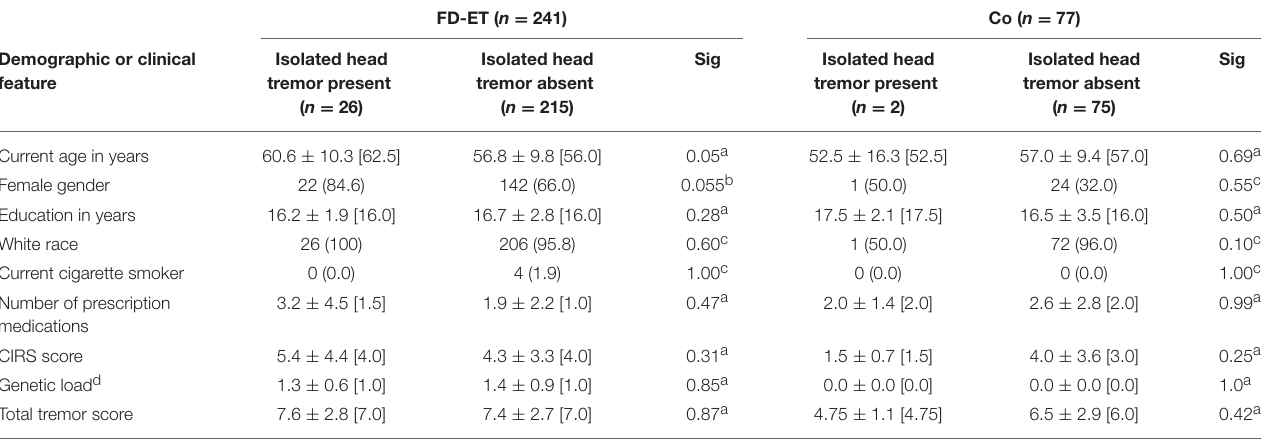
TABLE 2 | Demographic and clinical features of enrollees with vs. without isolated head tremor.